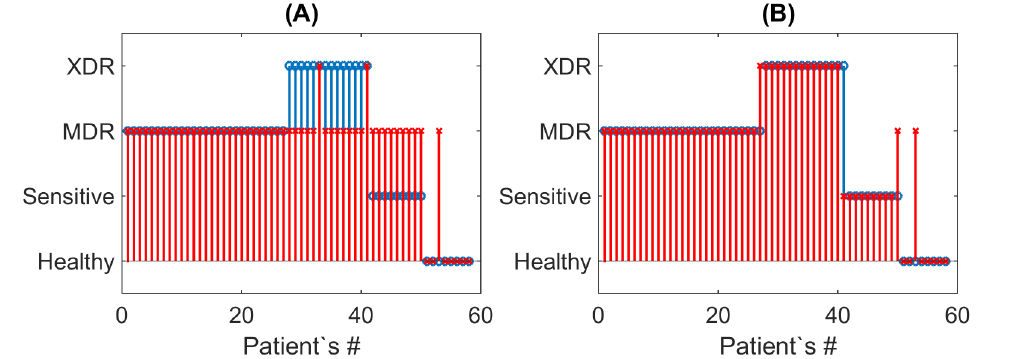
Figure 2. A comparison of the drug resistance statuses for the naïve ( A ) and improved ( B ) multi- classification approaches. Blue stems with circles and red stems with crosses mark the actual and predicted